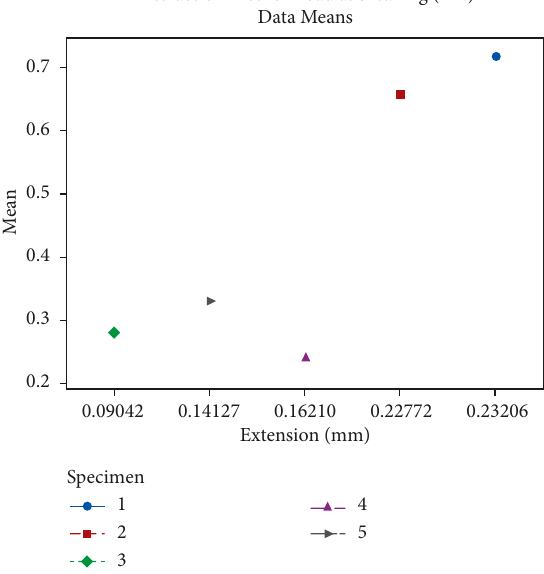
Figure 6: ANOVA interaction plot for load at breaking (KN) through